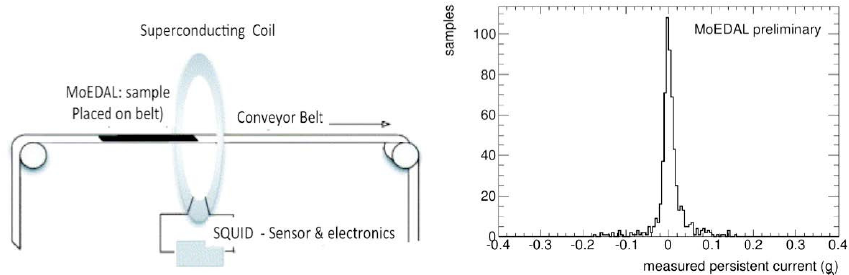
Figure 4. (Left) A schematic depiction of the use of a SQUID magnetometer to detect the presence of a trapped magnetic charge. (Right) The results of a SQUID magnetometer scan of MMT elements exposed to collisions as part of a MoEDAL test